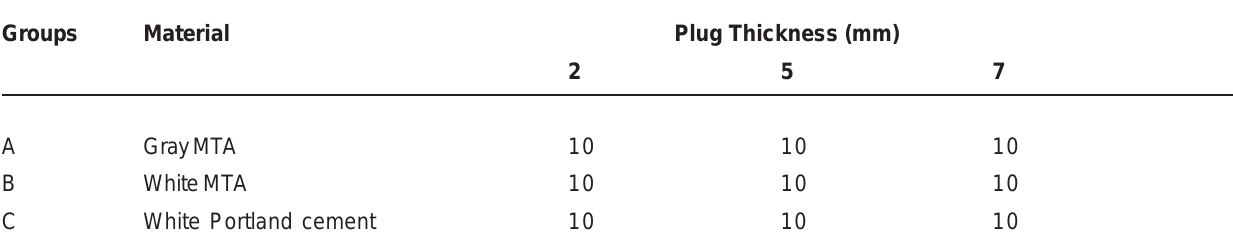
TABLE 1- Distribution of teeth in the groups with respect to the plug thickness and